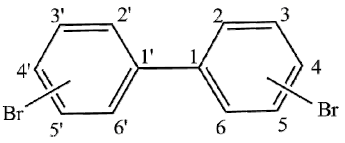
Figure 1. The common skeleton of polybrominated biphenyls (PBBs).